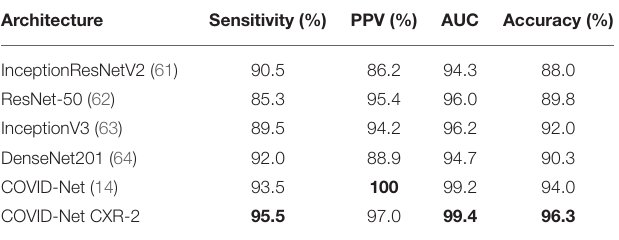
TABLE 3 | Quantitative analysis. Sensitivity, positive predictive value (PPV), area under receiver operator curve (AUC), and accuracy of COVID-Net CXR-2 on the test data from the CXR benchmark dataset in comparison to COVID-Net (14) and other state-of-the-art computer vision architectures. Best results highlighted in bold.